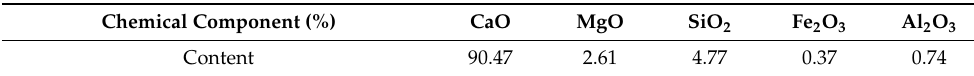
Table 4. Main chemical composition of quicklime.